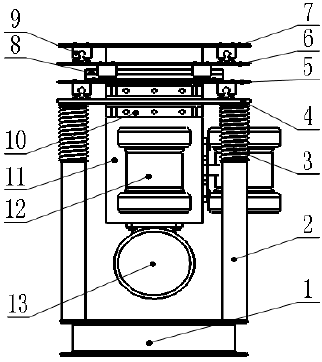
Figure 2. Schematic diagram of three-dimensional shaking table.